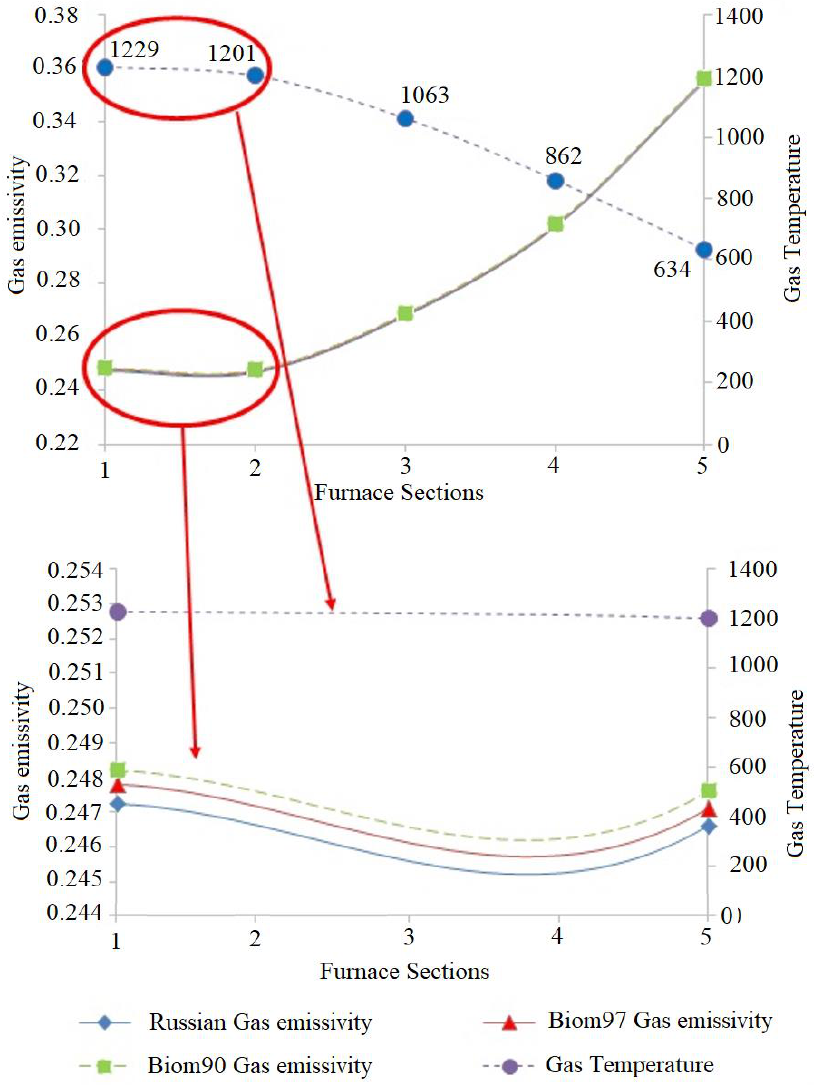
Figure 9. Gas emissivity per furnace section as a function of gas temperature.